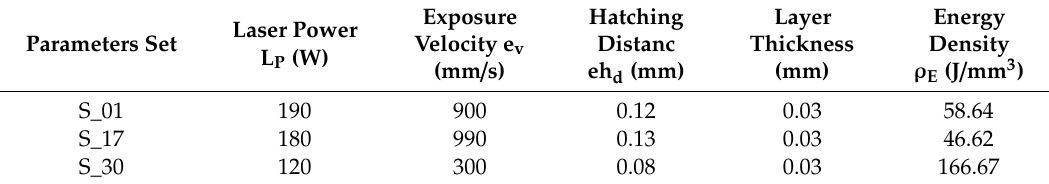
Table 2. Parameter groups used for sample manufacturing.